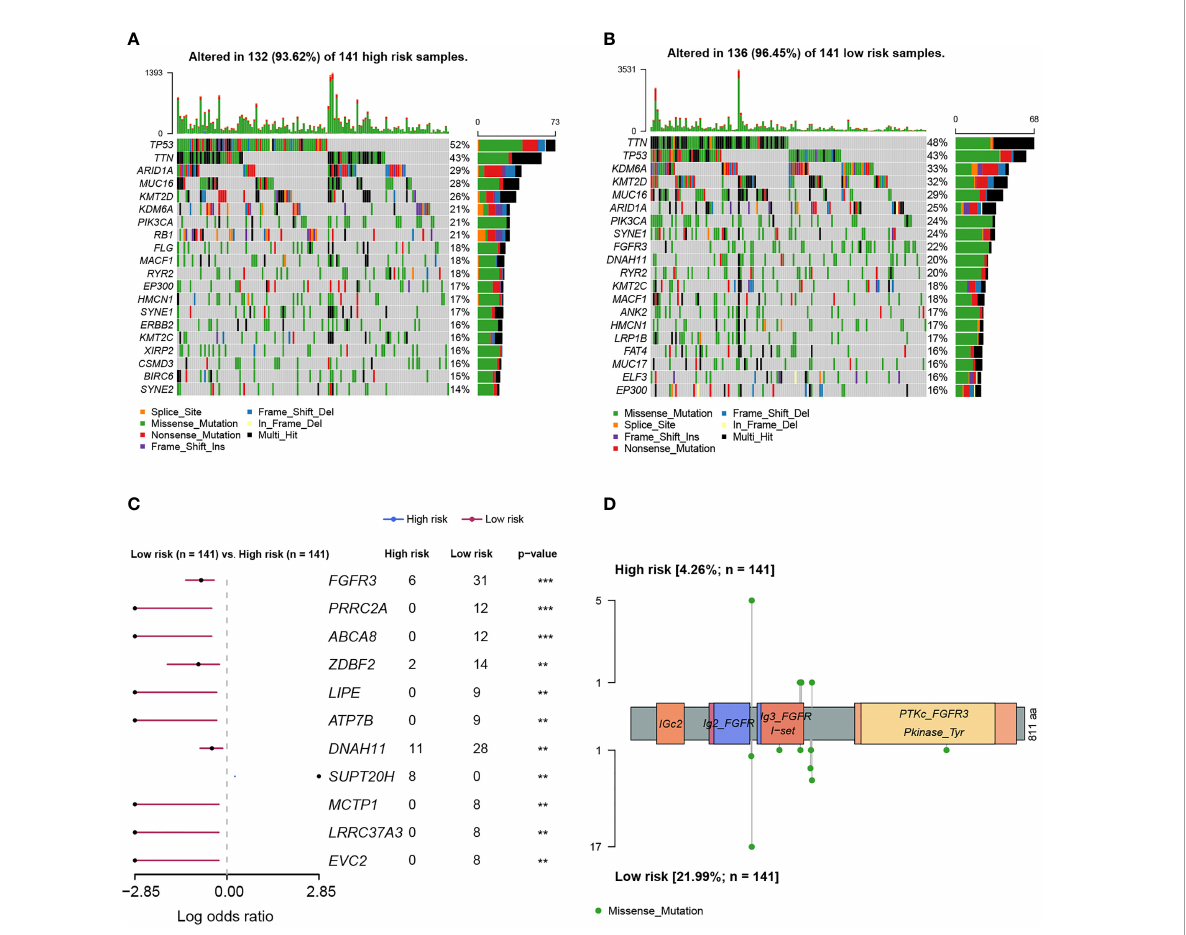
FIGURE 8 The differentiation analysis of genomic alteration landscapes between high- and low-risk groups. (A) The oncoplot demonstrated the genomic alteration pro fi le of high-risk samples. (B) The oncoplot demonstrated the genomic alteration pro fi le of low-risk samples. (C) The genomic alteration enrichment analysis between high- and low-risk groups. (D) The lollipop plot demonstrated the alteration sites of high- and low-risk samples. ** indicated p < 0.01, *** indicated p <